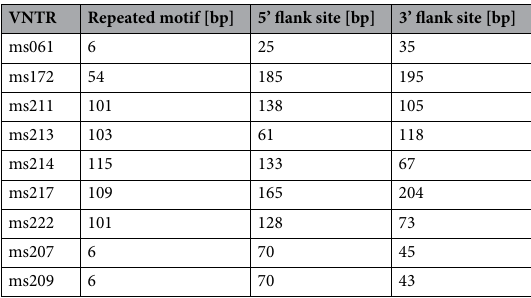
Table 3. The sizes of motif core and both 5’ and 3’ flanking